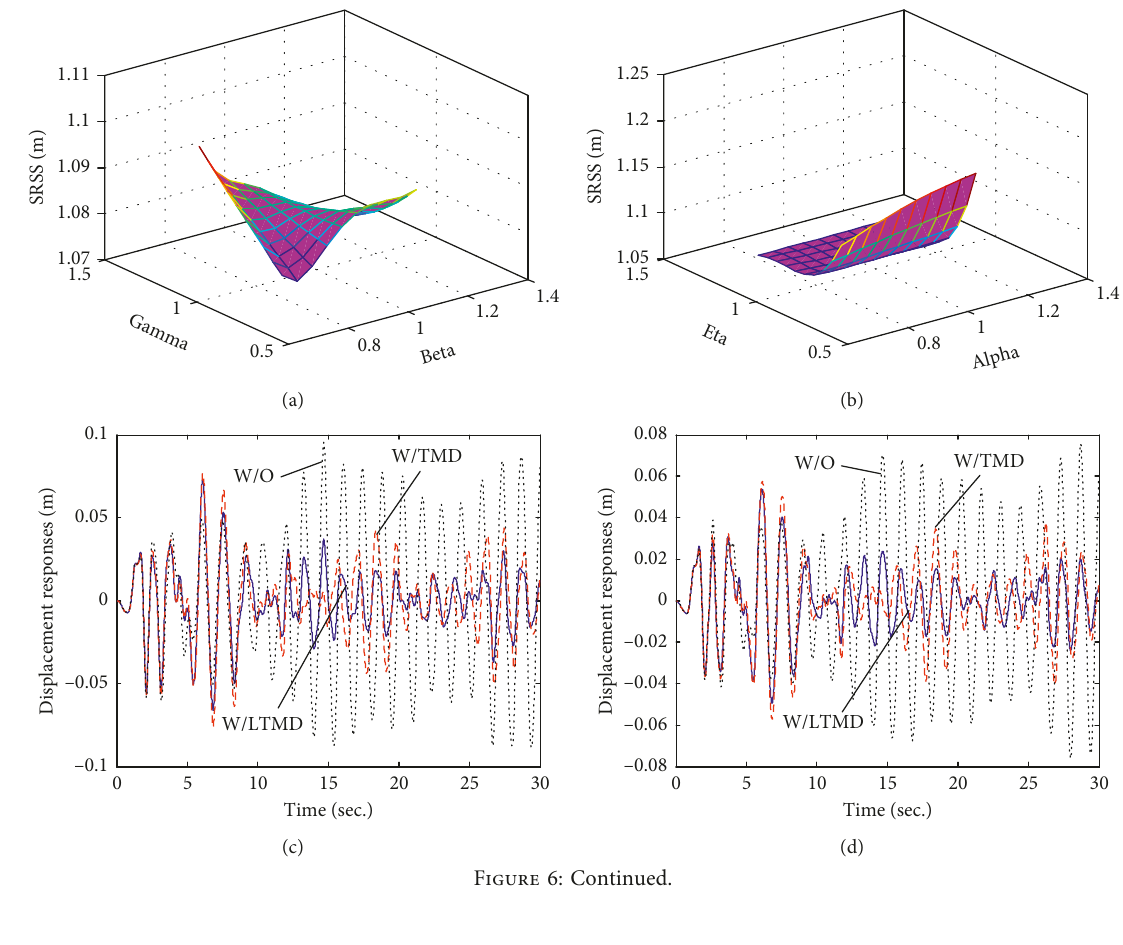
Figure 5: Numerical results of dynamic responses using the mass ratio μ at fixed values of α 0 . 8093 and η 1 . 0; (c) SRSS according to α and η at fixed values of β (cid:29) (cid:29) floor) at α 1 . 15, β 1 . 15, c 1 . 15, and η 1 . 0; (e) dynamic responses (2 nd floor); (f) dynamic responses (1st floor); (g) control forces at (cid:29) (cid:29) (cid:29) (cid:29) the upper mass of the